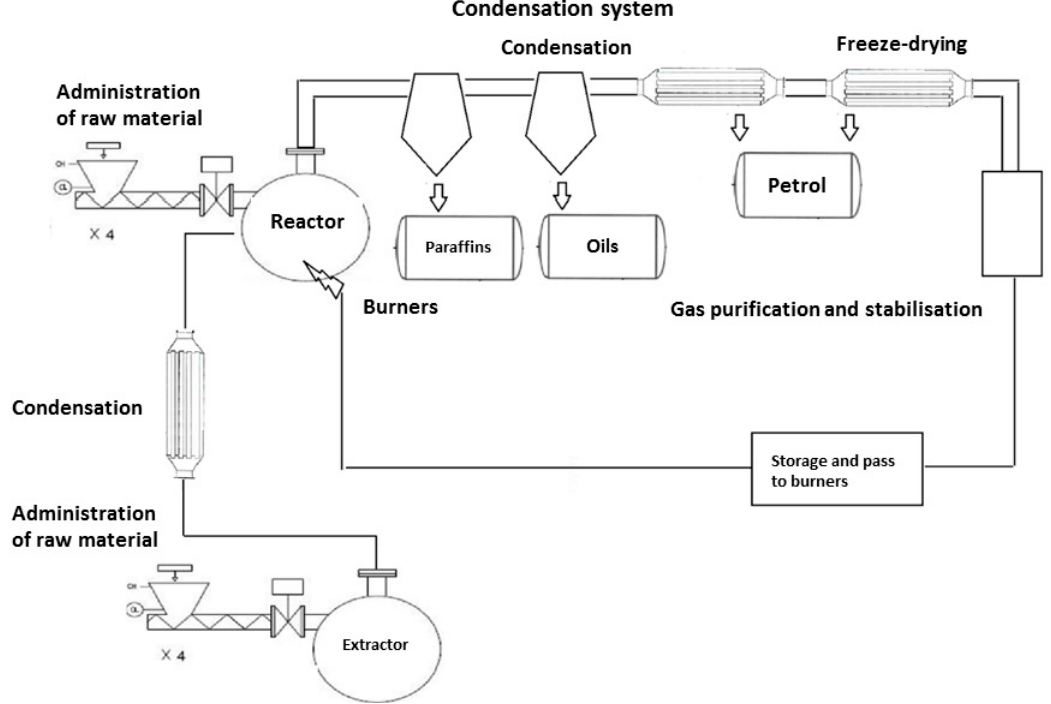
Figure 7. Schematic diagram of pyrolysis installation.